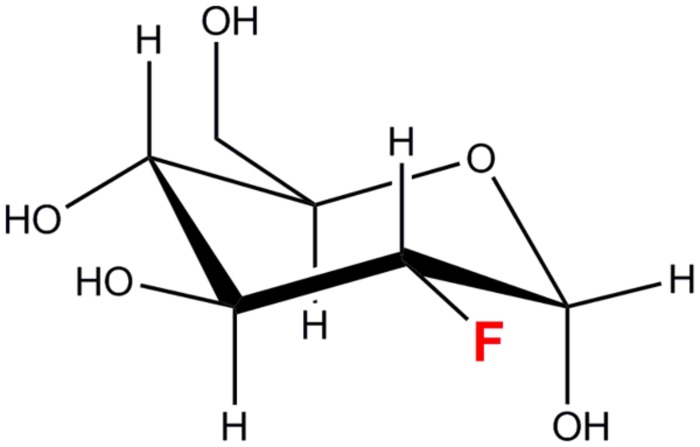
2-deoxy-2-fluoro-D-glucose (18FDG/FDG).